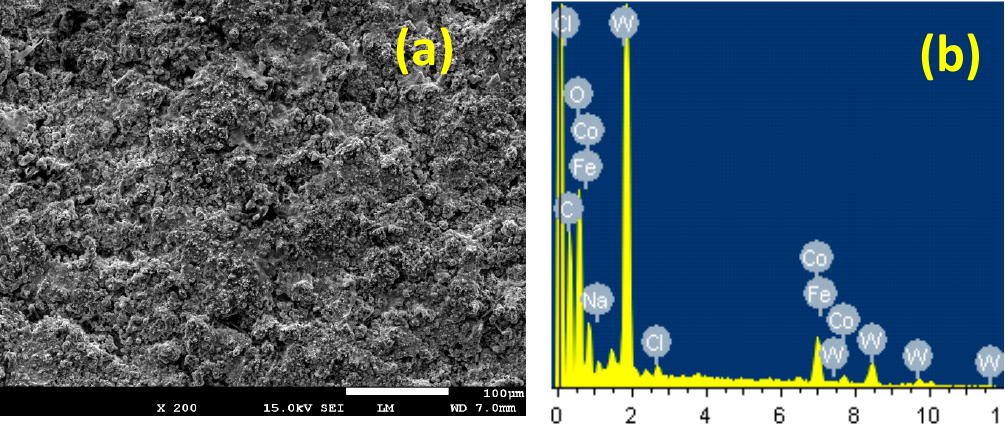
Figure 12. ( a ) The SEM image and ( b ) the corresponding EDX spectra for PS coated with 88%WC-12%Co in 4% NaCl solution for 48 h followed by fixing a potential value of − 700 mV for 40 min.